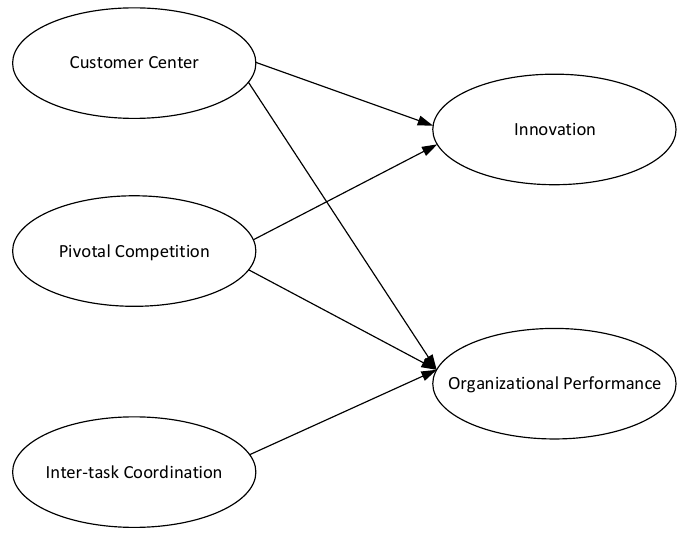
Fig. 1. Conceptual model of